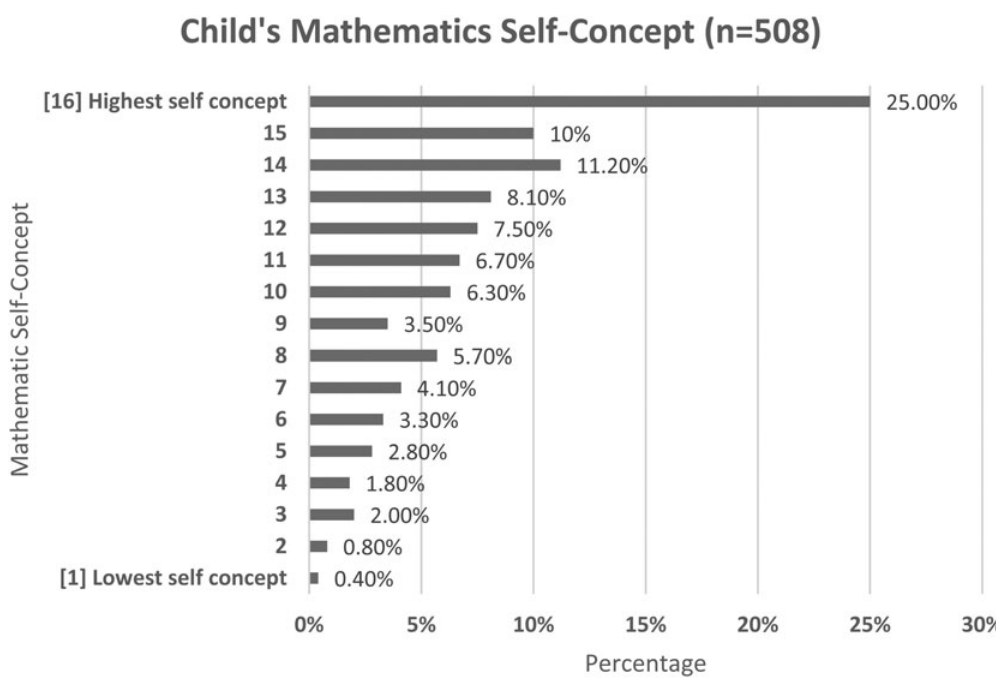
Fig. 1. Child ’ s mathematics self-concept ( n